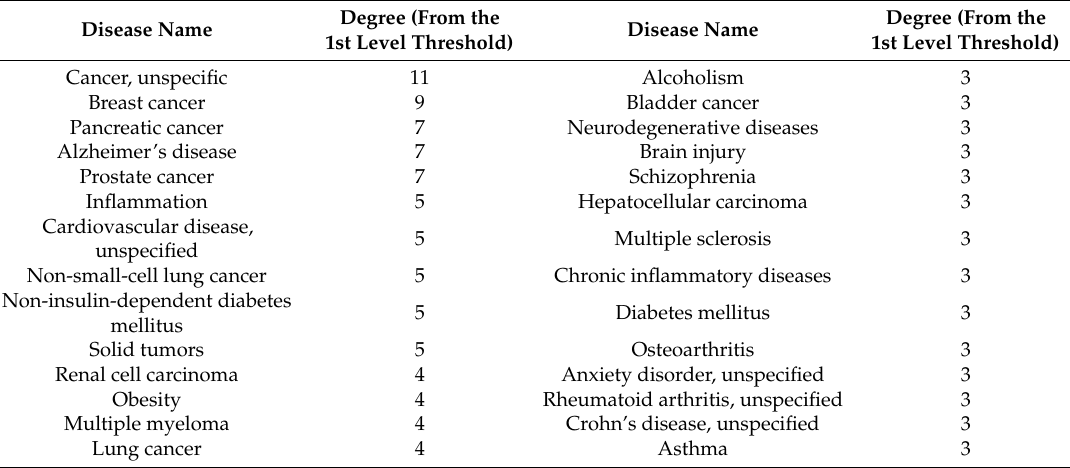
Figure 7. Degree matrices of the related diseases. Each row represents the major diseases of the CTD network, and each column represents the 10 thresholds of OB and DL. ( a ) The matrix shows the absolute degree of each disease. Only diseases with an average degree of 3 or higher are displayed. The color bar indicates the absolute degree of diseases. ( b ) The matrix represents the relative degree. Only the top 50% of diseases indicated by total herbs’ degrees are selected. The color bar represents the relative degree of diseases. Table 3. The potential target diseases based on the absolute degree matrix of Platycodon grandiflorum